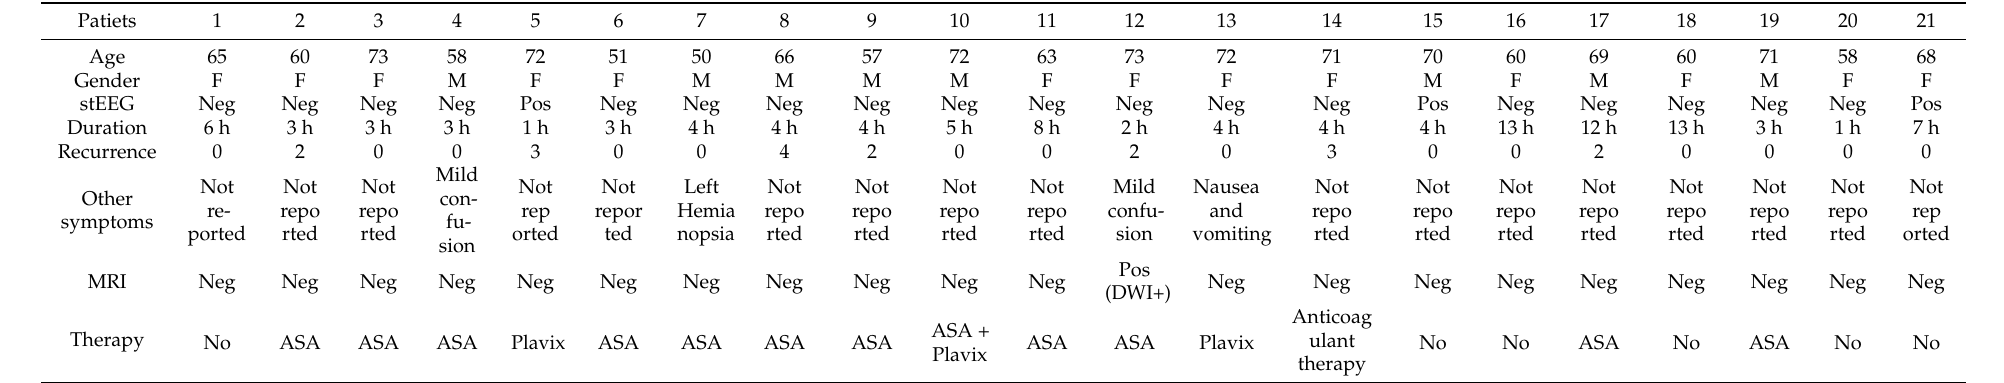
Table 2. Clinical, demographic and EEG characteristics of our TGA